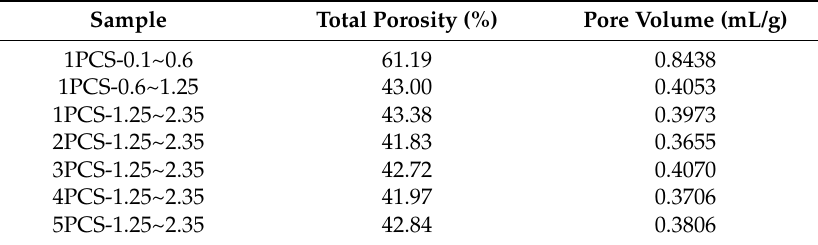
Table 4. The total porosity and pore volume of all PCS samples.